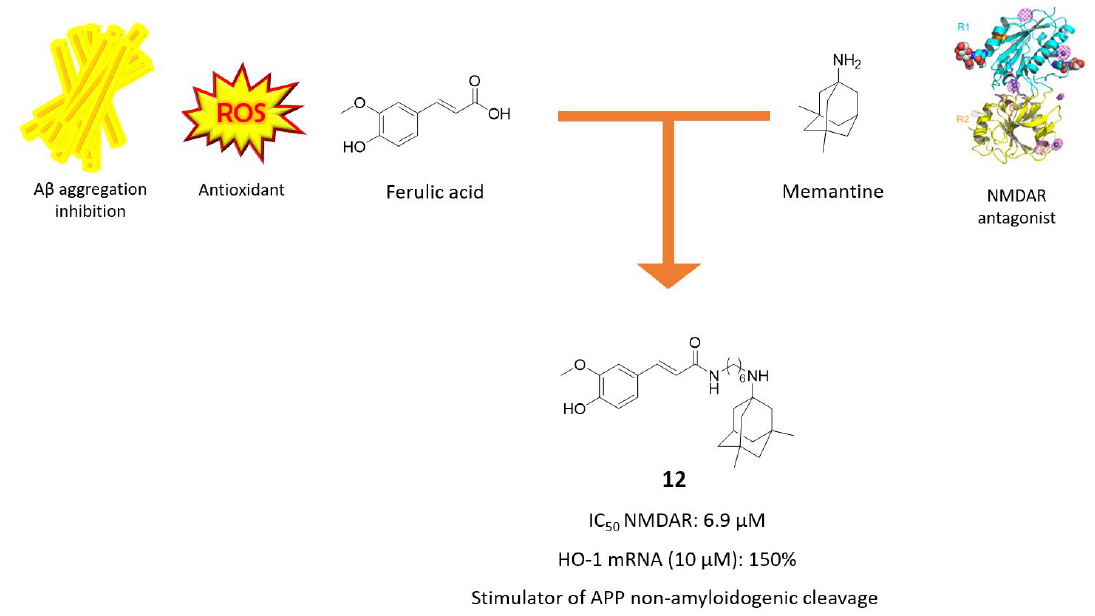
Figure 7. Drug design and biological activities of ferulic acid-memantine hybrid 12 .